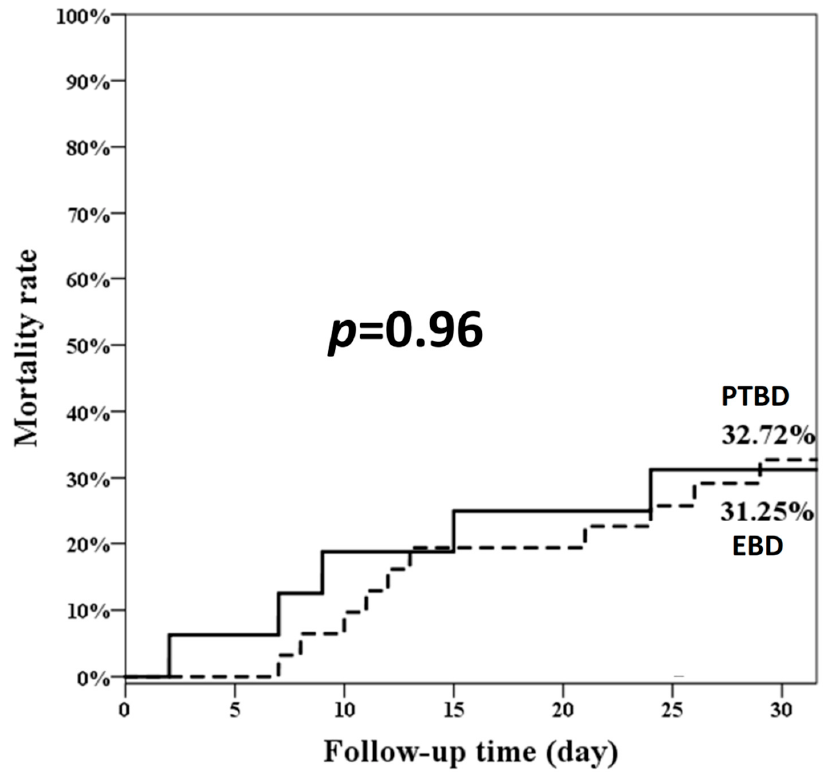
Figure 2. The overall 30-day mortality rate of the two groups. EBD: endoscopic biliary drainage; PTBD: percutaneous transhepatic biliary drainage. Table 4. Predictive factors associated with 30-day mortality.